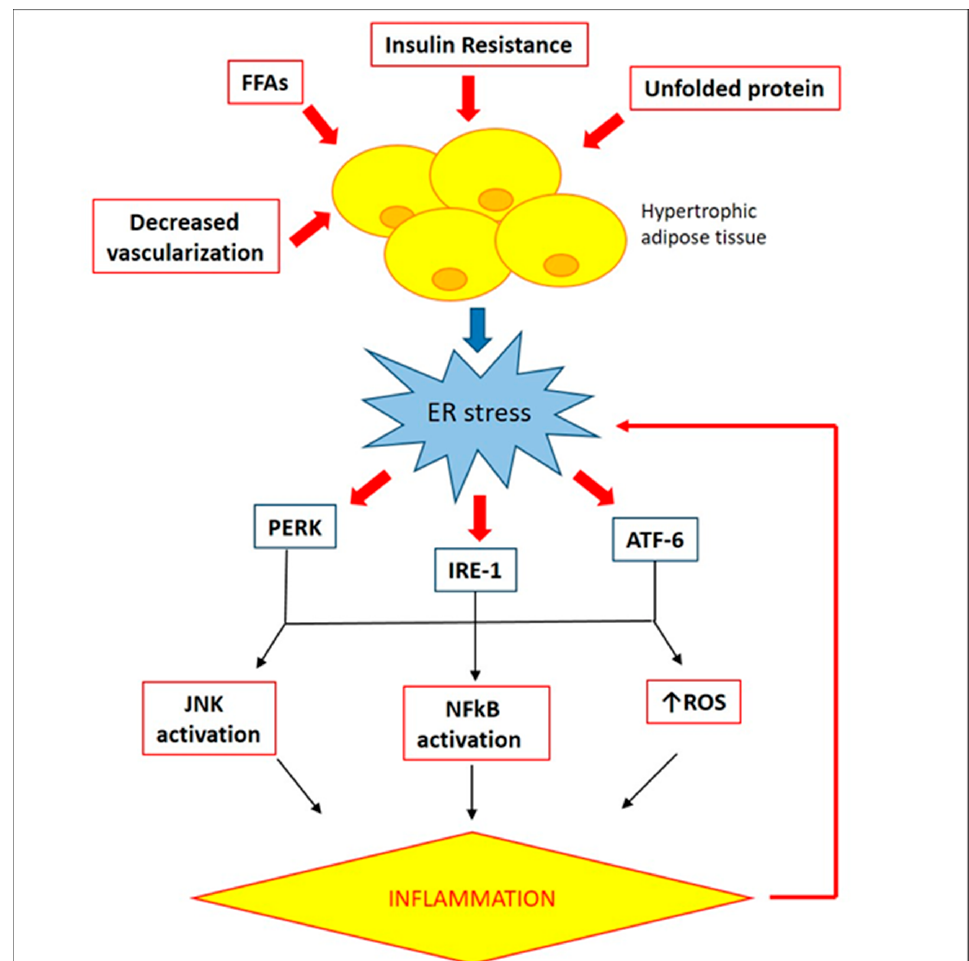
Figure 4. Involvement of ER stress in adipose tissue inflammation. In obese adipose tissue, accu- mulation of unfolded proteins, excess of FFAs, insulin resistance, and decreased vascularization determine ER stress, responsible of an inflammatory response via activation of JNK and NF- κ B pathways, as well as production of ROS.